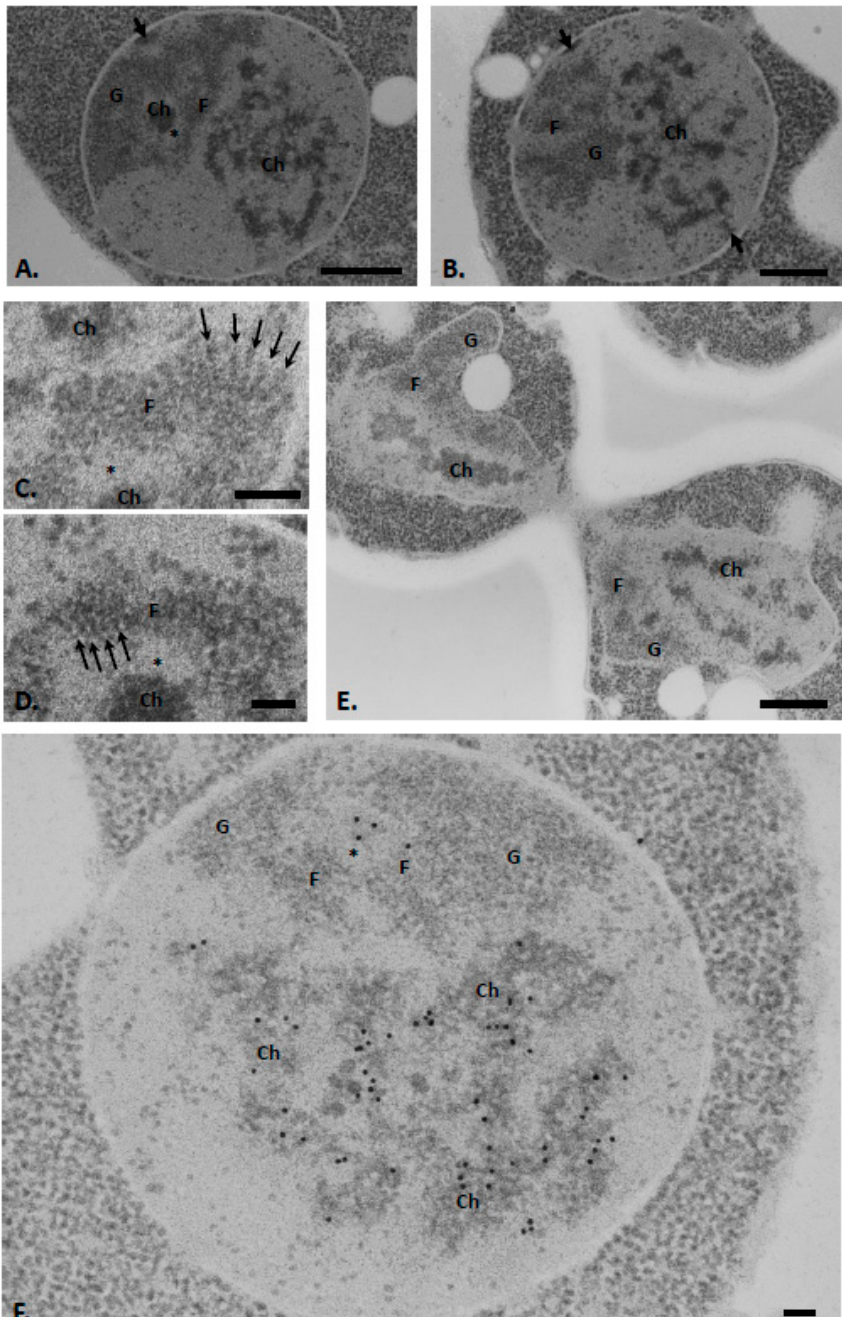
Figure 2. Nuclei of exponentially growing yeast cells exposed to hyperosmotic shock as revealed after the application of the cytochemical method of acetylation ( A – E ) combined with the immunological technique of DNA detection by the transferase of terminal deoxyribonucleotides ( F ). ( A , B ) Dense masses (Ch, chromatin) are mainly observed in the nucleoplasmic region. Heterogeneous areas (asterisks) in the nucleolar region also contain patches of condensed chromatin. Some dense masses conspicuously associated with the nuclear envelope (thick arrows). ( C , D ) Some portions of the fibrillar strands ( F ) of the nucleolus have a pennate appearance with remarkable alignment (thin arrows). ( E ) Cell in division showing the presence of dense masses of compacted chromatin in the two forming nuclei. ( F ) Gold particles labelling DNA are observed essentially on the nucleo- plasmic and intranucleolar dense masses. F, fibrillar strands; G, granular zone. Bars = 0.5 ( A , B , E ) or 0.1 µ m ( C , D , F